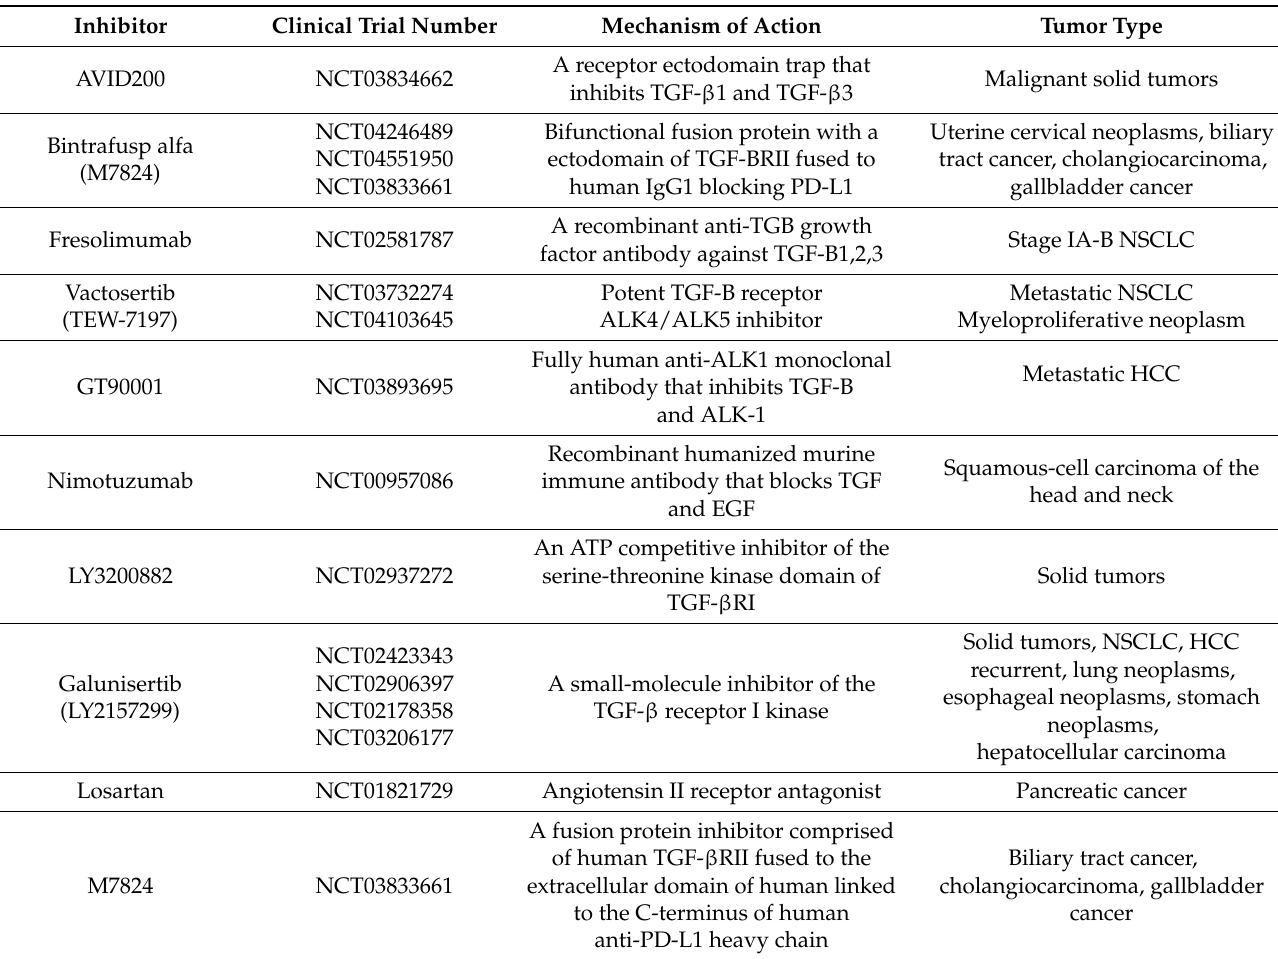
Table 1. TGF- β Inhibitors in Active Cancer Clinical Trials. The Clinicaltrials.gov (accessed on 9 September 2021) database was used to assess active, interventional clinical trials for cancer treatment within all phases of development. Clinical Trial Search link (accessed on 1 August 2021):